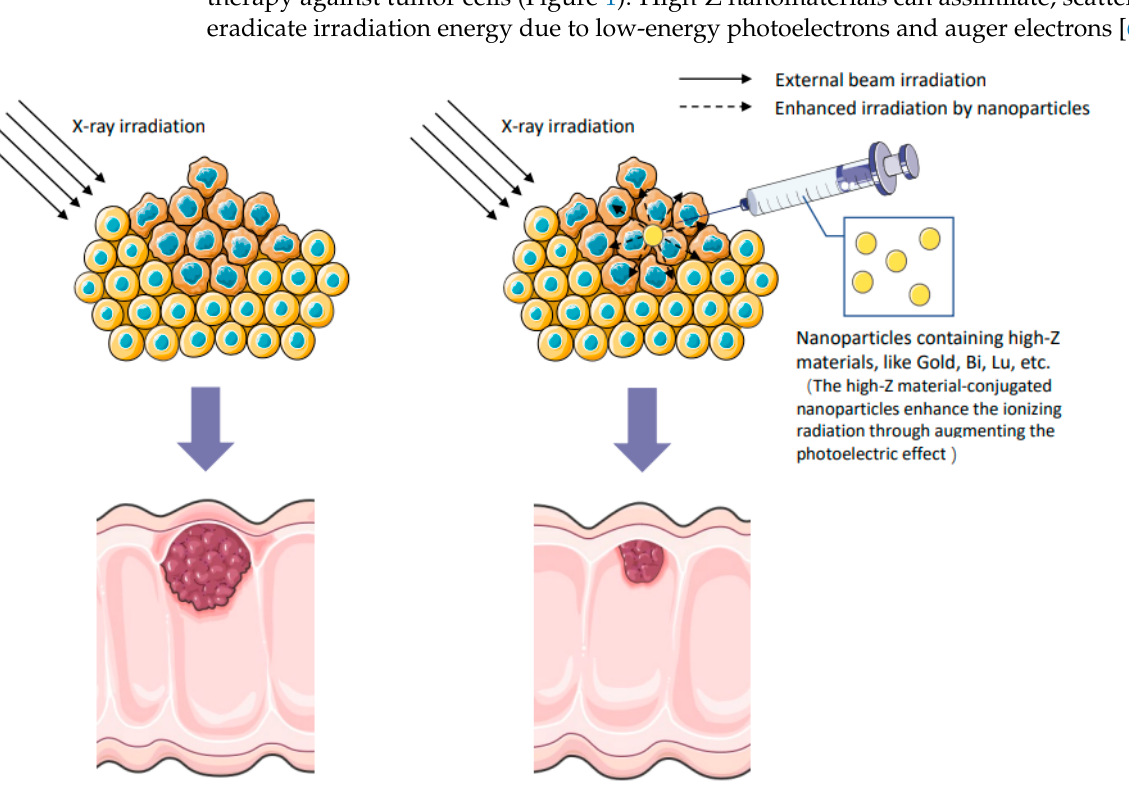
Figure 1. Comparative schematic depiction of implications of high Z-effect metal (Au, Bi, Lu) nanoparticles containing radiosensitizing drug moieties for alleviating tumor growth through enhancing the X-ray irradiation-induced damage when compared to radiation therapy alone. The high-Z material-conjugated nanoparticles enhance the ionizing radiation through augmenting the photoelectric effect.